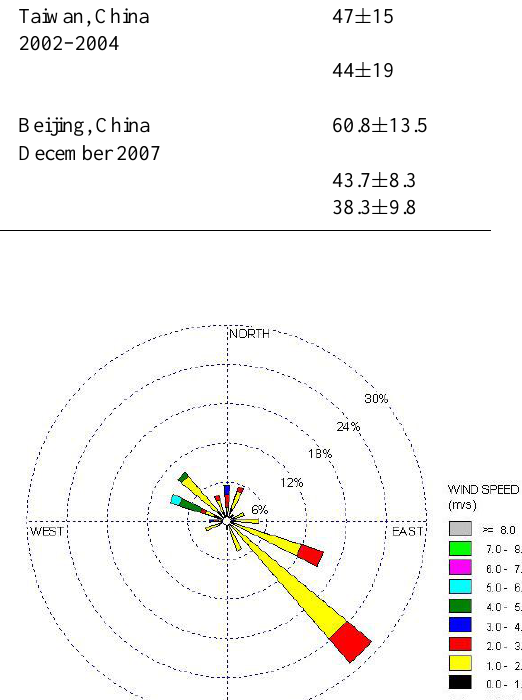
Fig. 4. Temporal evolutions of (a) relative humidity and temperature vertical section, (b) surface relative humidity, and (c) surface temperature.